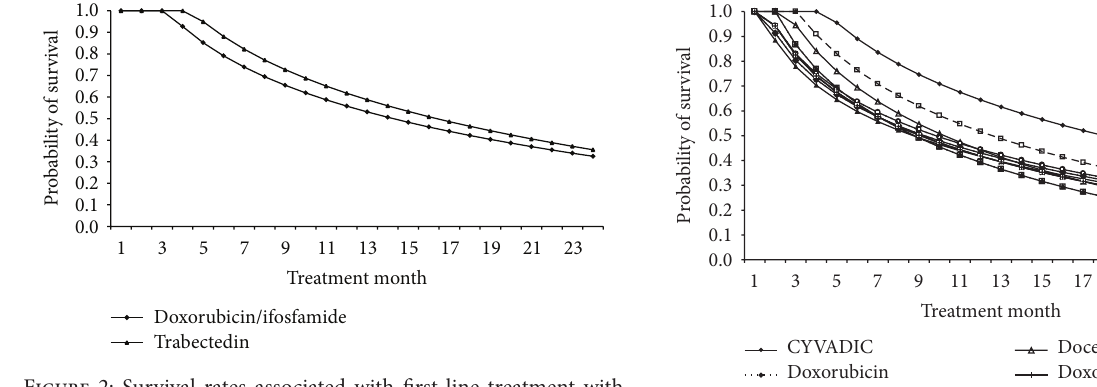
Figure 2: Survival rates associated with first-line treatment with doxorubicin/ifosfamide and trabectedin.